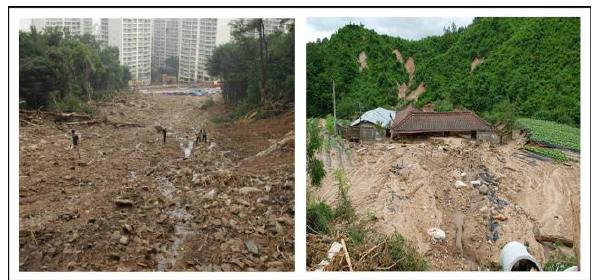
Figure 1. Examples of debris flow damage in South Korea The Mt. Umyeon debris flow disaster that occurred in Seoul in 2011 resulted in casualties and property damage, and showed that debris flows can occur not only in mountainous areas, but also in urban environments. Given the hazards posed by high- speed debris flows in mountainous and urban areas, many researchers have sought to forecast landslide-induced debris flows to minimize damage (Ko et al., 2014).